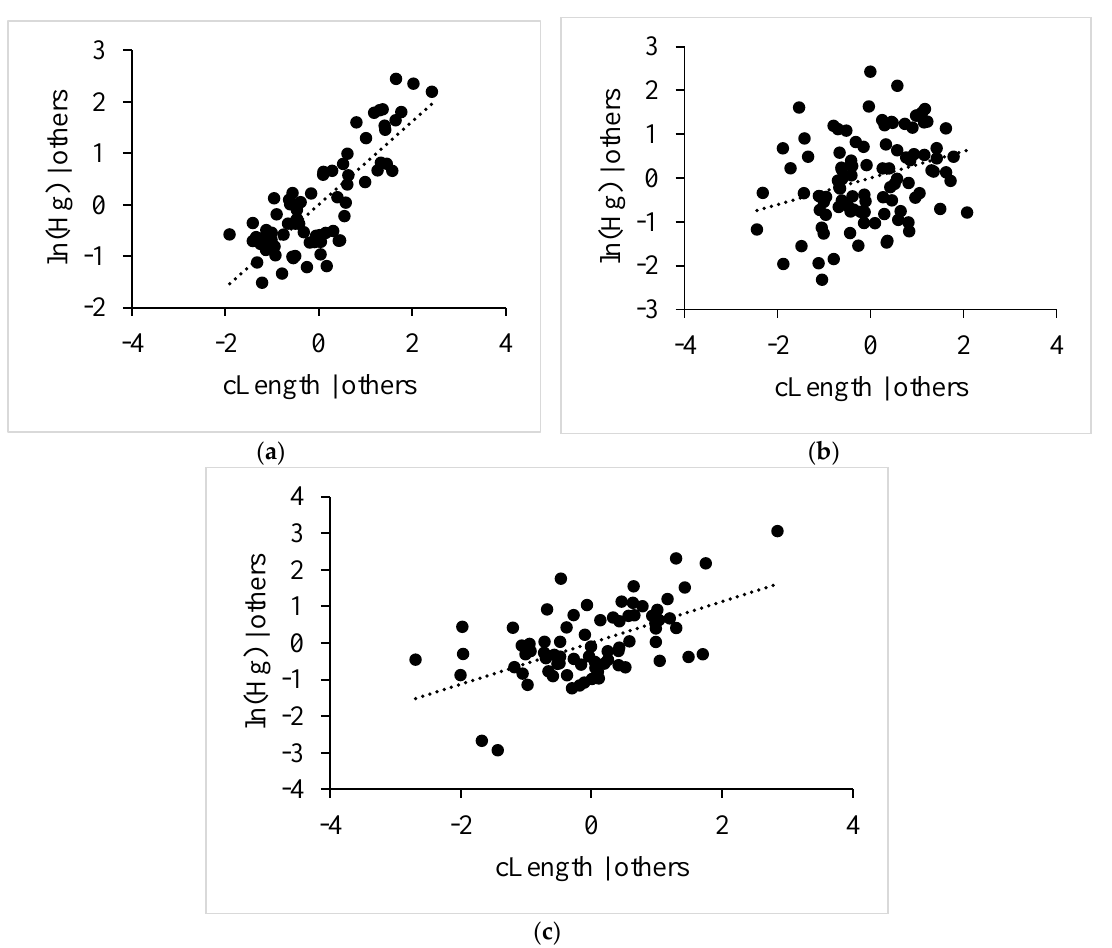
Figure 4. Partial linear regressions using the centered, transformed length as explanatory variable, and logarithmically transformed Tot-Hg as response variable, both corrected for all other variables included in the models for; ( a ) A. charr; ( b ) E. smelt; ( c ) whitefish.